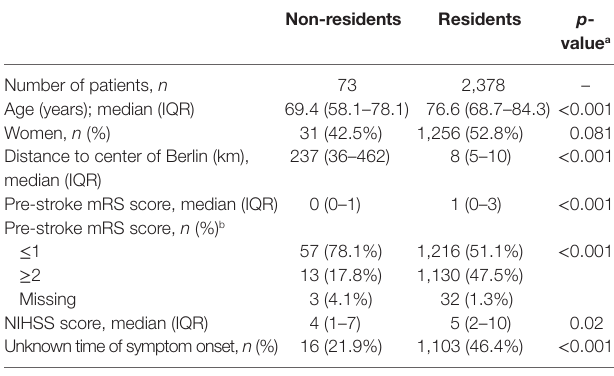
TaBle 1 | Baseline characteristics of non-resident and resident stroke